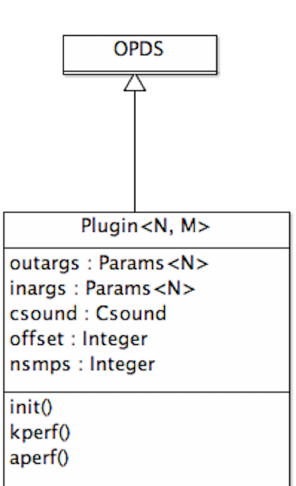
Figure 1. The Plugin template base class, derived from the opaque C structure OPDS